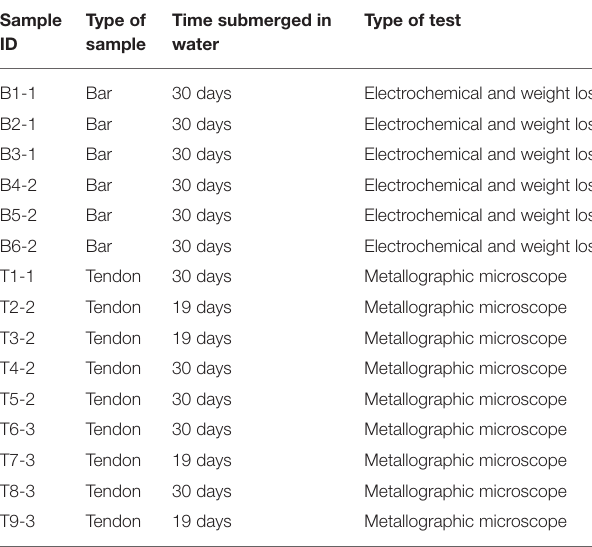
TABLE 2 | Summary of samples and tests performed.